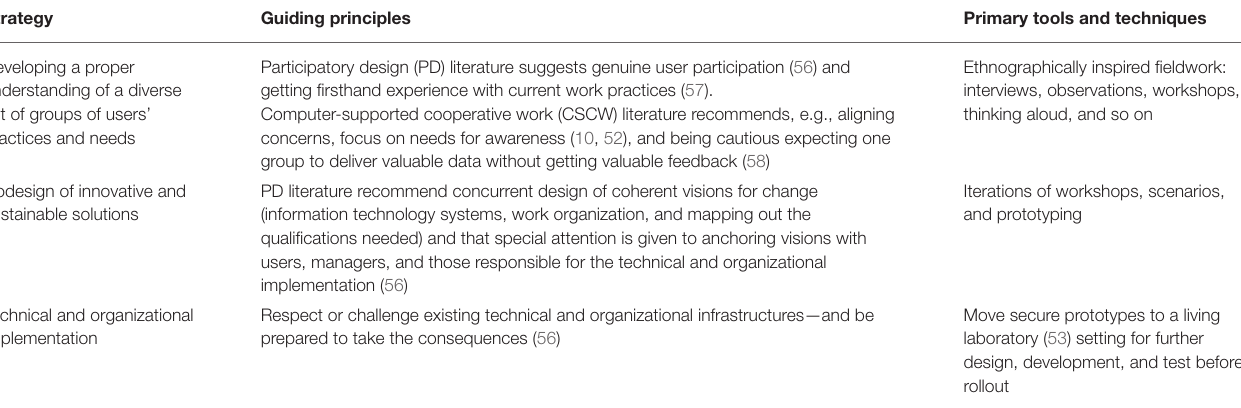
TABLE 1 | Challenges, guiding principles, and tools and techniques in implementing user-centered design. Strategy Guiding principles Primary tools and